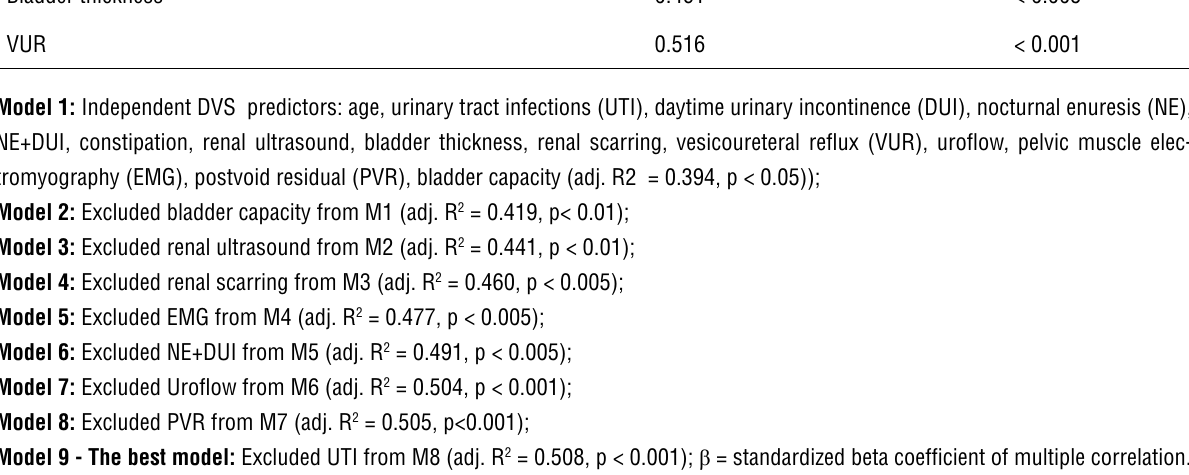
Table 3 - Multiple linear regression analysis for dysfunctional voiding score (DVS) determinants with backward selection. Best model parameters β Age